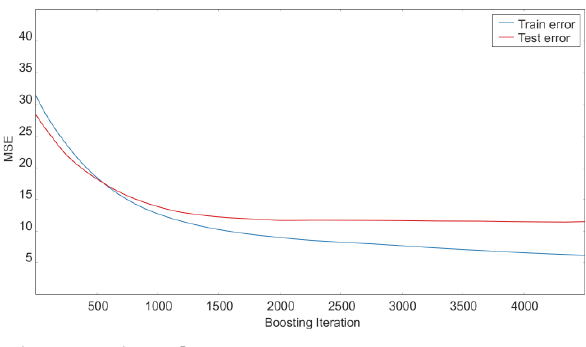
Figure 2: Deviance Plot